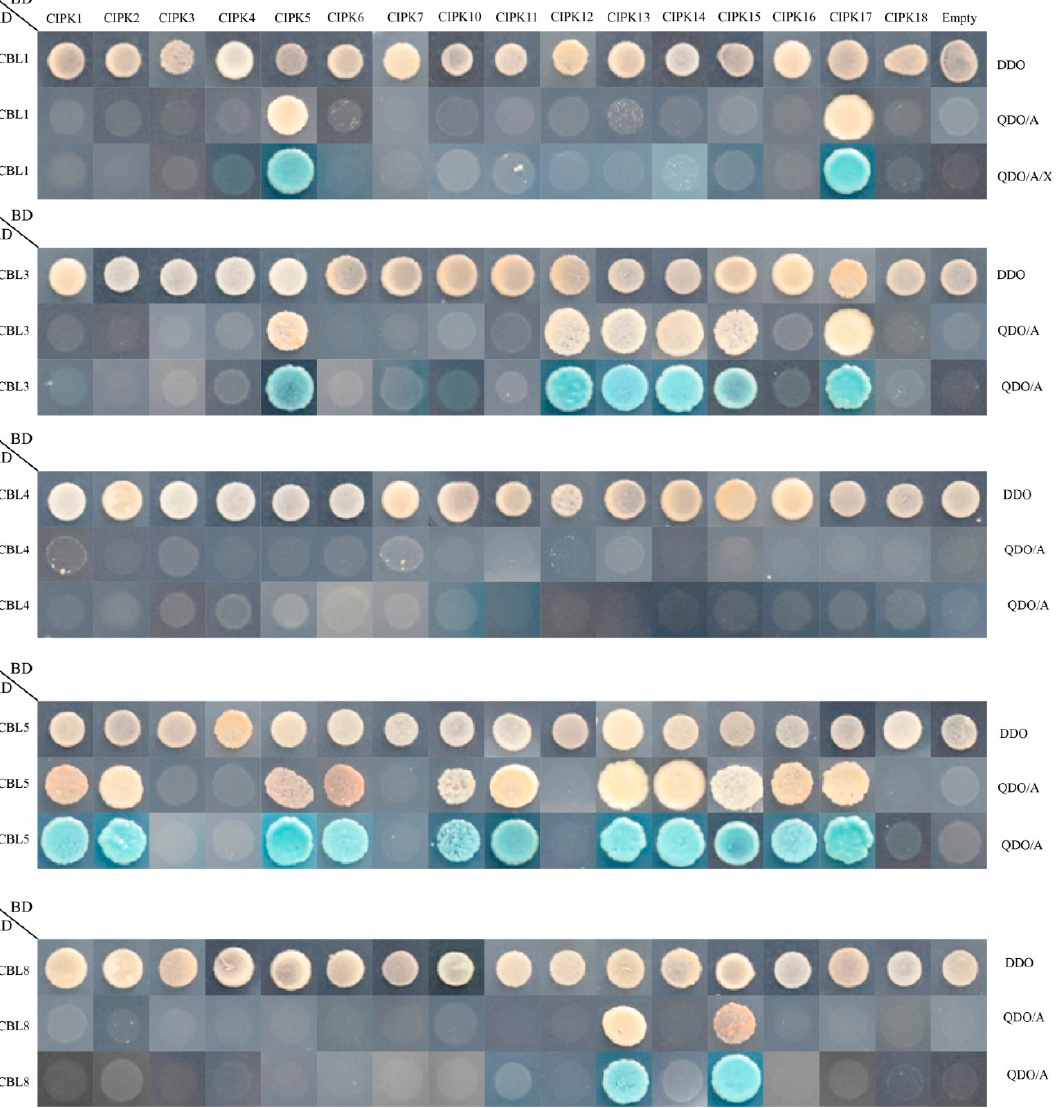
Figure 7. Protein ‒ protein interactions between peach CBL and CIPK proteins. The positive hybrid yeast cells were grown on SD-Trp-Leu (DDO), SD-Trp-Leu-His-Ade + AbA (QDO/A) and SD-Trp- Leu-His-Ade + AbA media supplemented with X- α -Gal (QDO/A/X) to check the interactions.